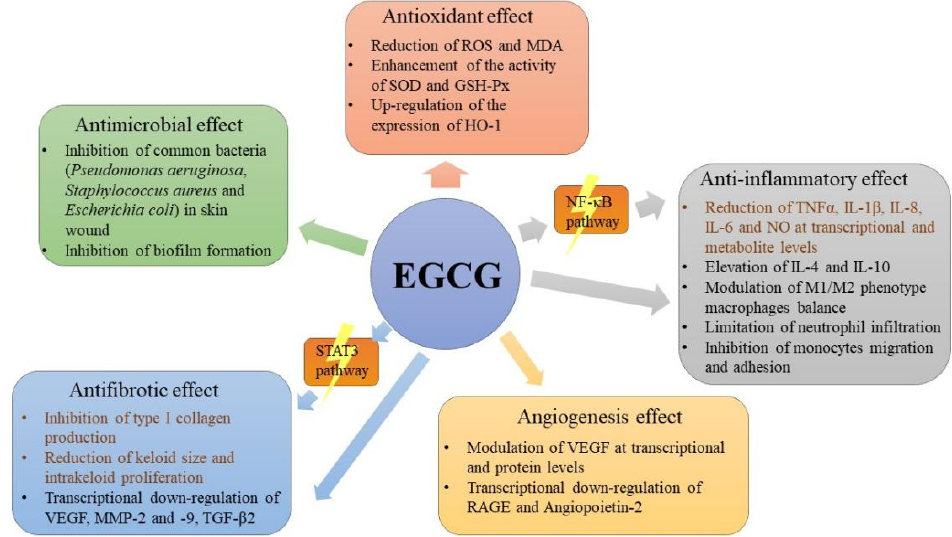
Figure 3. The possible mechanisms underlying the beneficial effects of EGCG on skin wound heal ‐